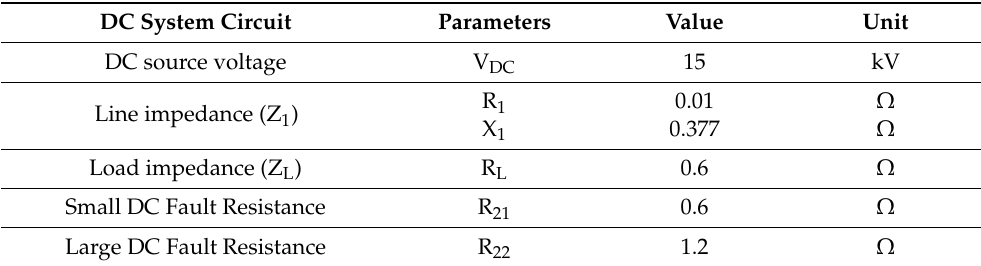
Table 1. Specification of DC System for DC Short-Circuit Tests.